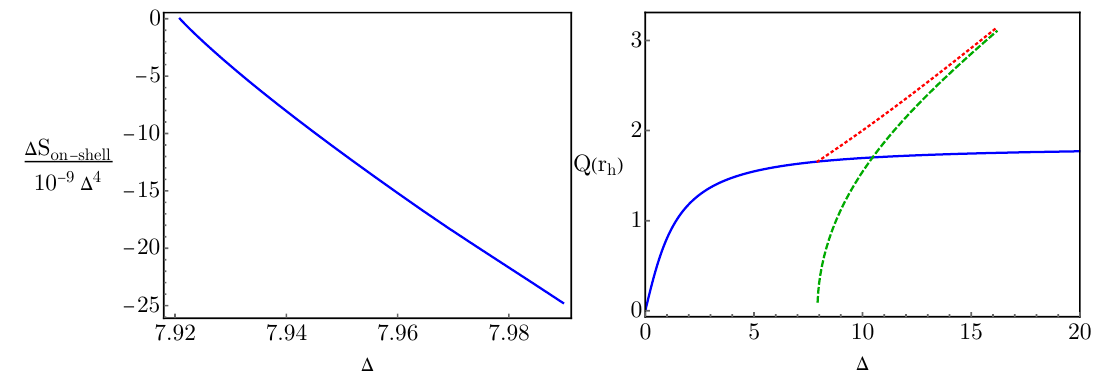
Figure 2 . Left: di(cid:11)erence of free energies between the xy nematic condensate phase and the nematic phase. Right: horizon value for the di(cid:11)erent Q i . The solid blue curve corresponds to the mWSM or normal phase Q ( r h ). We also plot Q 1 ( r h ) (dotted red) and Q 2 ( r h ) (dashed green) for the xy nematic condensate